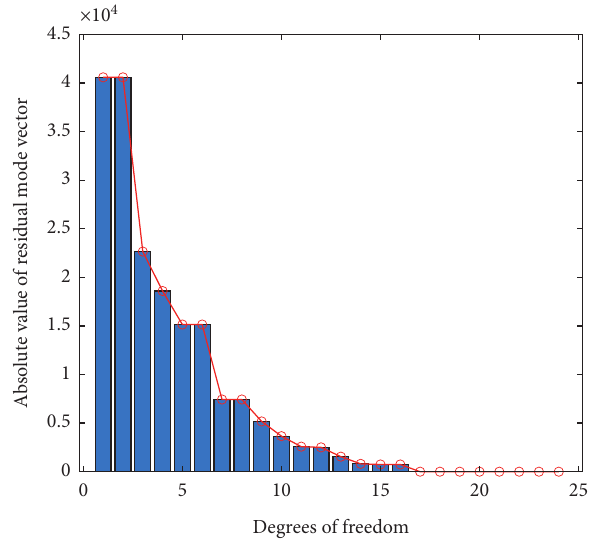
Figure 4: The location map of the damage